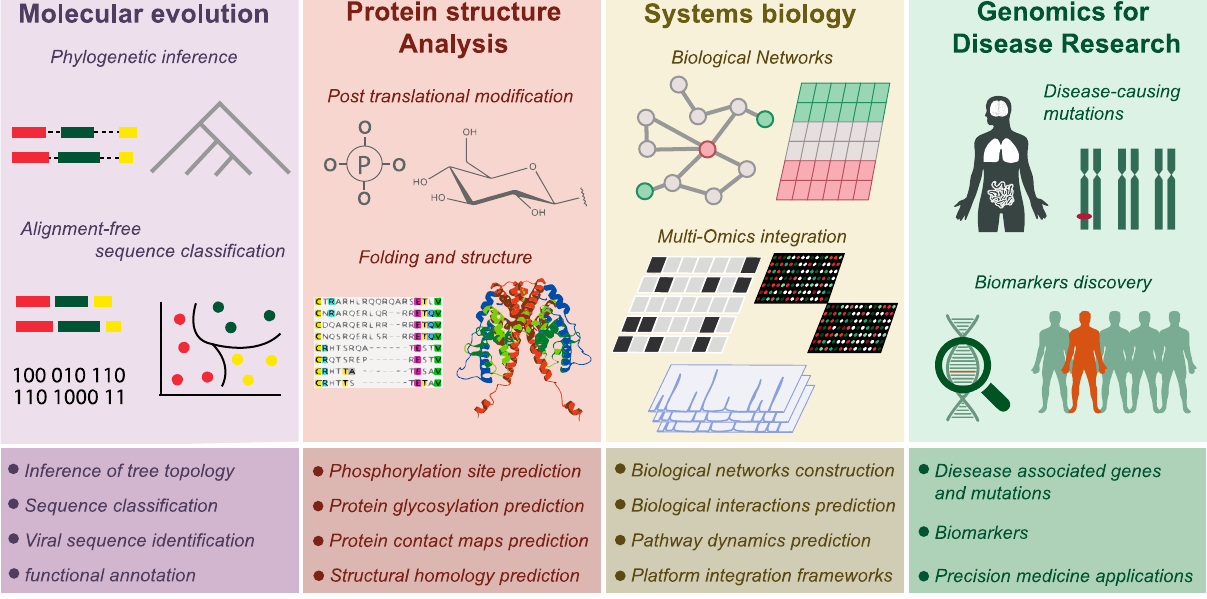
Figure 2. Applications of integrated machine learning techniques with bioinformatics in molecular evolution, protein structure analysis, systems biology, and disease genomics.